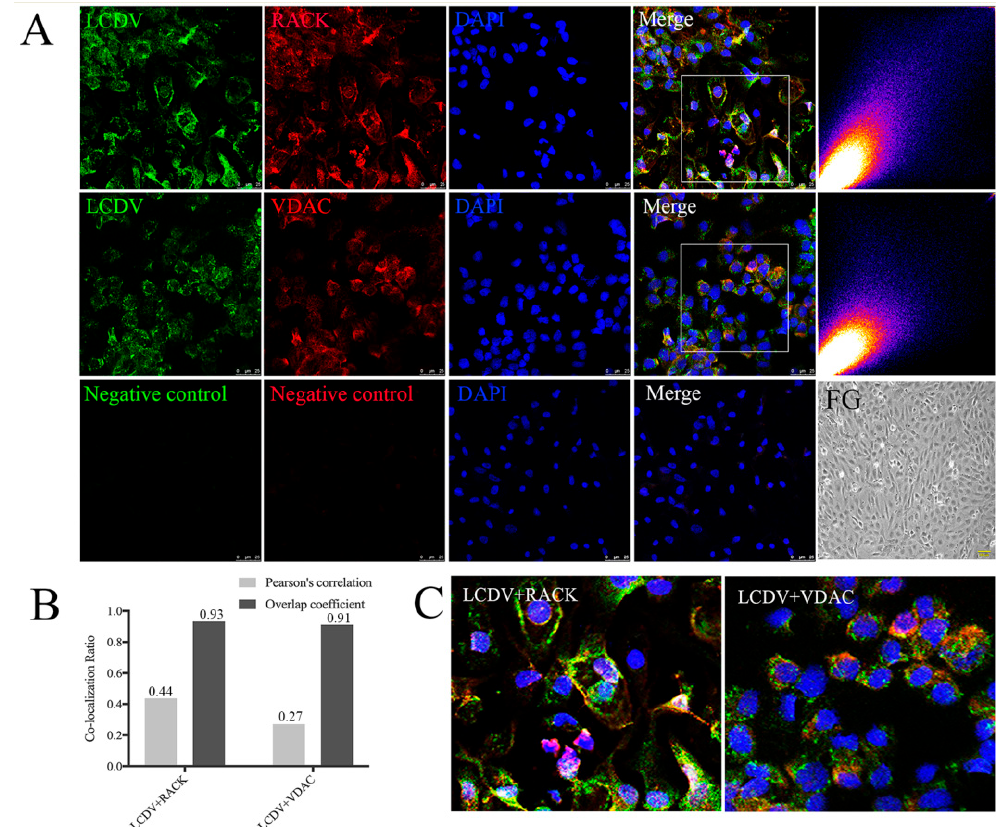
Figure 8. Co-localization of LCDV with VDAC2 and RACK1. ( A ) The co-localization of LCDV with VDAC2 and RACK1 analyzed by confocal microscopy; scatter plots represent co-localization analysis of the merged images using ImageJ software, the diagonal shape of the scattered blots indicated a high level of co-localization, bars = 25 μ m. Uninfected FG cells were shown as a control, bars = 100 μ m. ( B ) Pearson’s correlation and overlap coefficients of the merged images analyzed by ImageJ software. ( C ) Higher magnification on framed areas of merged figures in ( A ). Rabbit pre-immune serum paired with mouse pre-immune serum instead of primary antibodies served as a negative control. The virus inoculation was conducted at 22 °C for 2 h.